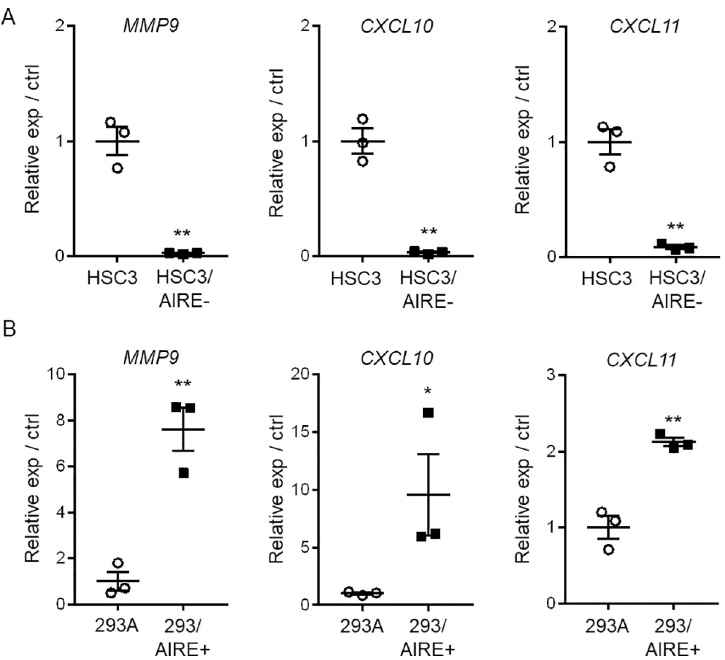
Fig 5. Relative expression of proinflammatory genes. Gene expression in A) HSC3/AIRE – , and B) 293/AIRE+ in comparison to respective non-transformed cells as measured by real-time RT-PCR. GAPDH was used for normalization. Data are shown as the mean + SEM of technical triplicates and are representative of three independent experiments. � P < 0.05, �� P < 0.01, by Student’s t -test.